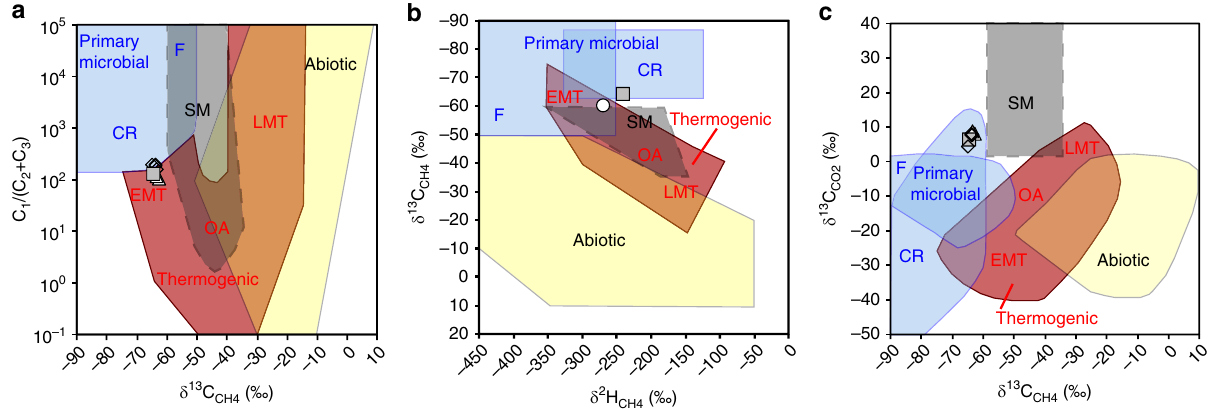
Fig. 7 Gas composition discrimination diagrams. ( a ) δ 13 C CH4 versus C 1 /(C2 + C 3 ). ( b ) δ 2 H CH4 versus δ 13 C CH4. ( c ) δ 13 C CH4 versus δ 13 C CO2 (adapted from 32 ). Position of the gases from boreholes VM2 (diamonds = gas samples, triangle = water samples), VM5 (square) and drinking water well (circle) are shown. Genetic gas fi eld abbreviations denote: CR CO 2 reduction, F methyl-type fermentation, SM secondary microbial, EMT early mature thermogenic, OA oil-associated thermogenic, LMT late mature thermogenic gas. Gas data were extracted from the database of AB Igrene (Supplementary Data 8), and from 45 (drinking well at Gulleråsen close to Solberga, δ 13 C CH4 : − 60.3 ‰ , δ 2 H CH4 : − 269 ‰ ). The sampling site of the gas data in borehole VM2 corresponds to the uppermost 13 C-rich calcites in this borehole, whereas the other gas-sampled borehole (VM5) is just adjacent to other boreholes sampled for calcite (VM- and 01-boreholes). Errors (2 σ ) are within the size of the